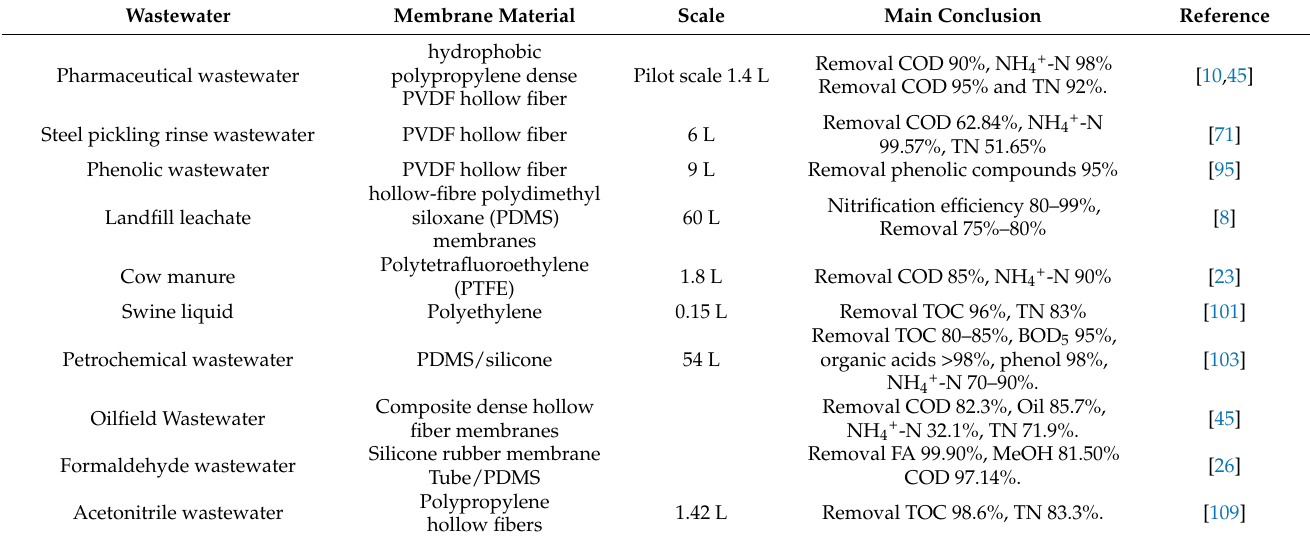
Table 3. Performance of MABR in treating different industrial